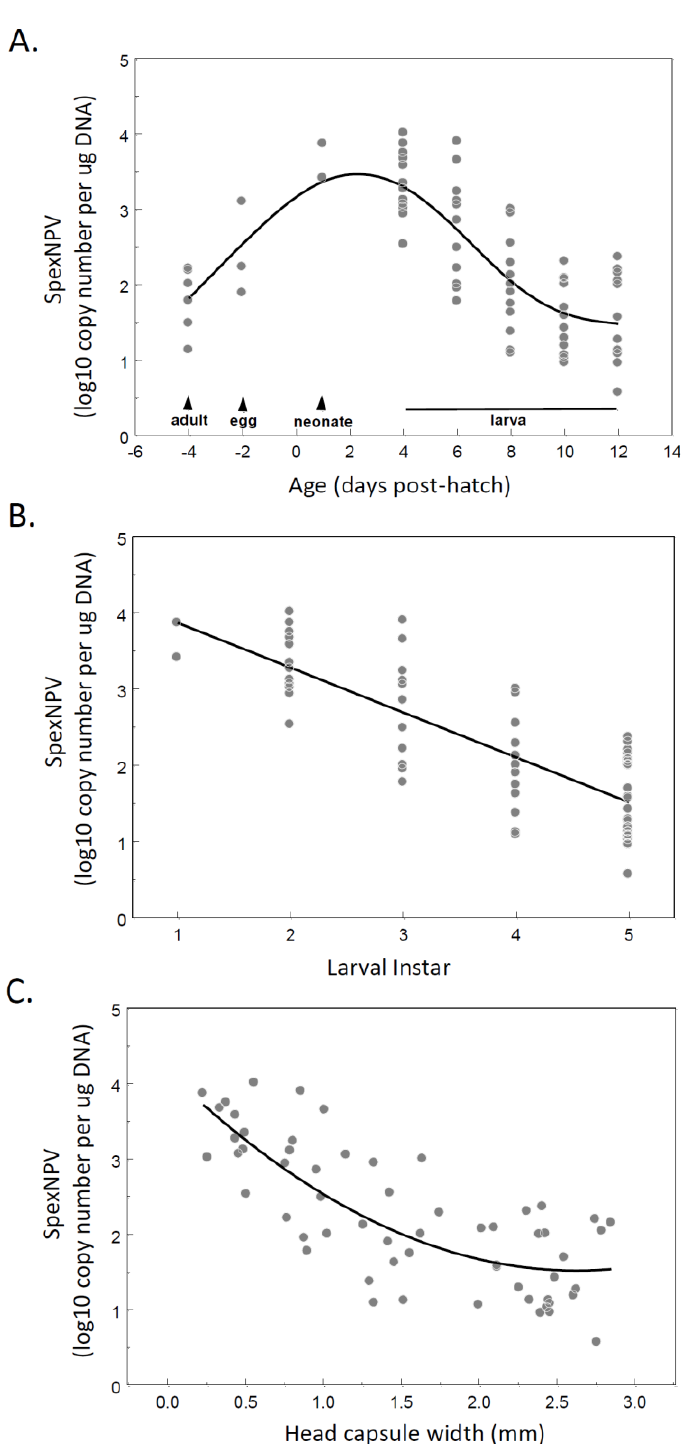
F 2,56 = 43.3, p < 0.0001; Figure 1c).